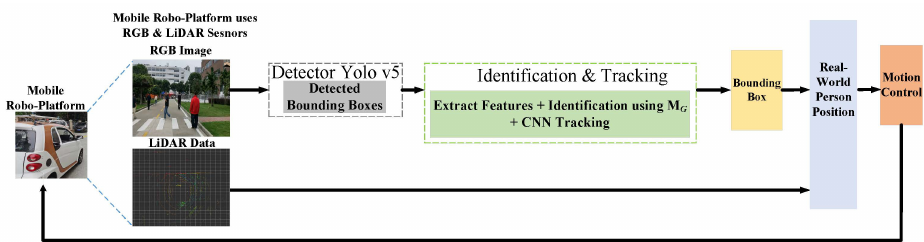
Figure 19. System Overview of Person-Following Robot in Our